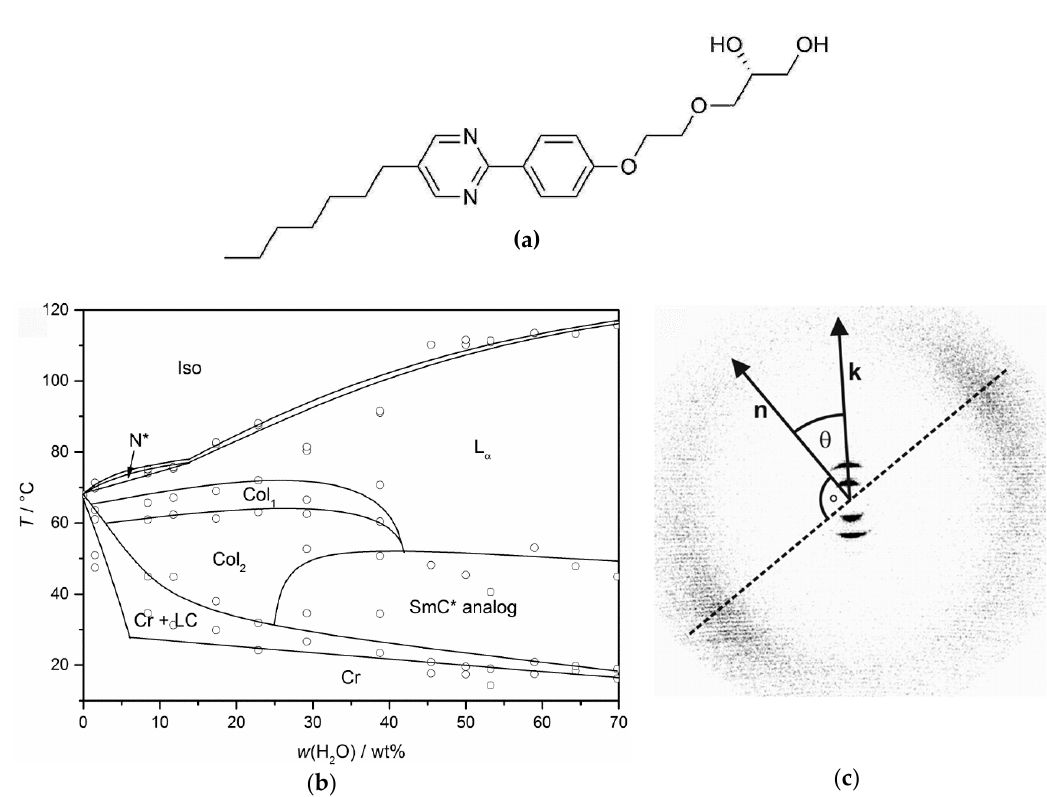
Figure 10. The chiral diol depicted in ( a ) forms true lyotropic SmC* phases in mixtures with water and formamide. ( b ) The phase diagram with water exhibits a cholesteric (N*), two different columnar phases (Col 1 and Col 2 ), a L α phase and the lyotropic SmC* phase. ( c ) A two-dimensional X-ray diffraction pattern of the aligned phase provides clear evidence that the probed lyotropic phase possesses a structure analogous to the thermotropic SmC* phase. (Phase diagram reprinted by permission from John Wiley and Sons: [29]; X-ray pattern reprinted by permission from Springer Nature: [13].)